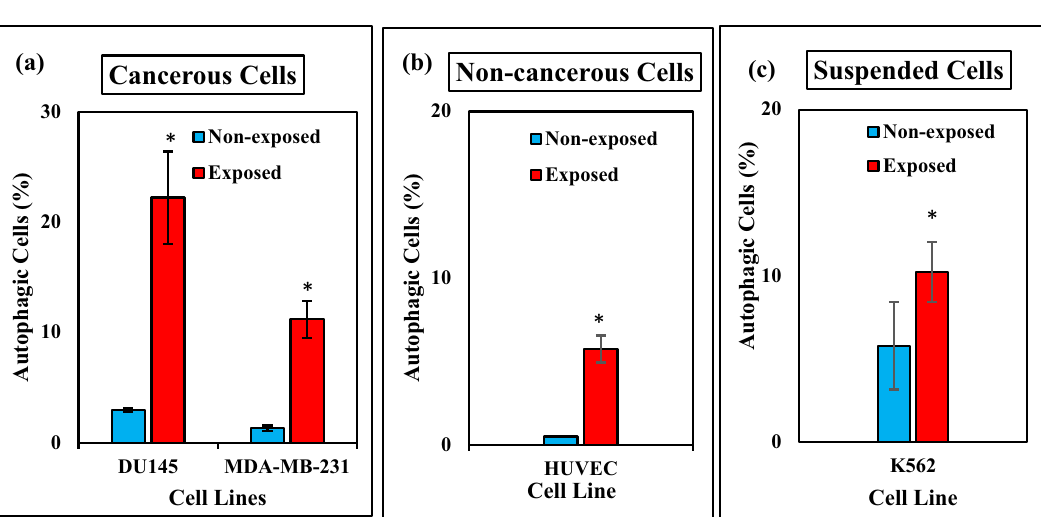
Figure 12. ELF-EMF induced autophagic cell response. We used Flow cytometry to determine the effect of ELF-EMF on autophagy response of DU145, K562, HUVEC cell lines (0.01 Hz, 100 mT, 120 h), and MDA-MB-231 cell line (1 Hz, 100 mT, 120 h). Bar plot showing the quantitative analysis of flow cytometric results non-exposed and exposed ( a ) cancerous, ( b ) non-cancerous, ( c ) suspended cells under ELF-EMF exposure stained with AO fluorescent dye. Bars indicate means ± SEM obtained from three or more independent experiments. Statistical significance between non-exposed and exposed groups was evaluated by a t-test. ( P -value < 0.05) was considered to indicate statistical